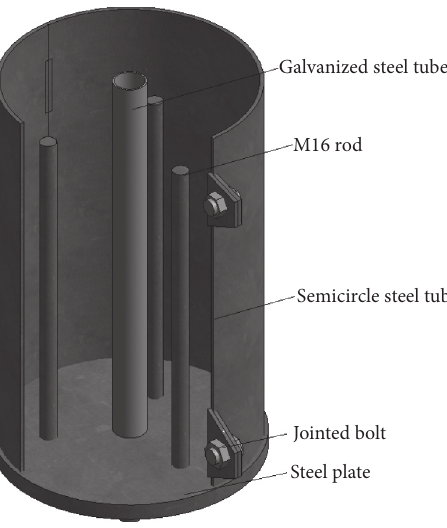
Figure 1: Diagram of the